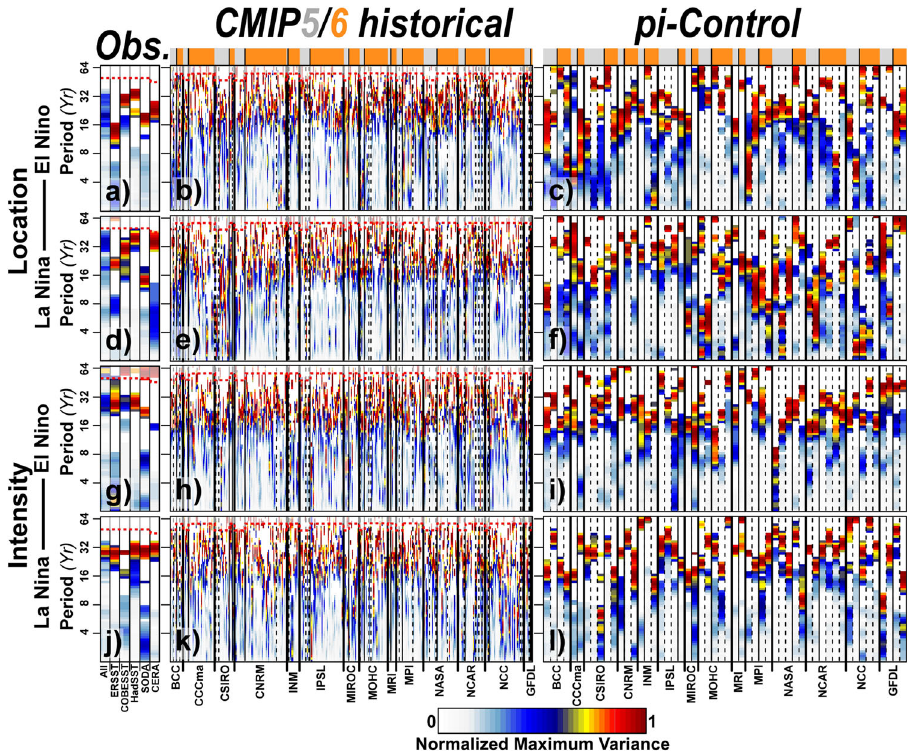
Fig. 4 Variability in ENSO ’ s, observed and simulated, most likely location and intensity. Maximum power spectra of the running 10-year El Niño most likely location (i.e., the mode), as determined using continuous wavelet analysis, and using ( a ) fi ve long-term observational reference datasets (left: ERSST.v5, COBESST.v2, HadSST1, SODA.si3, and CERA20C), ( b ) 95/250 CMIP5/6 historical runs (middle), as well as ( c ) 26/28 CMIP5/6 piControl runs (right). d – f Same as ( a – c ) but for La Niña. g – l Same as ( a – f ) but for El Niño and La Niña intensity. Only signi fi cant variability patches at p = 0.05, as determined using 1000 Monte-Carlo simulations of the red noise-background spectrum, are shown. Dashed red lines and grey shading indicate the area where variability can be underestimated because of edge effects, wraparound effects, and zero padding. As the continuous-wavelet analysis allows to account for temporal changes, the maximum power spectra are estimated using the full length of each time